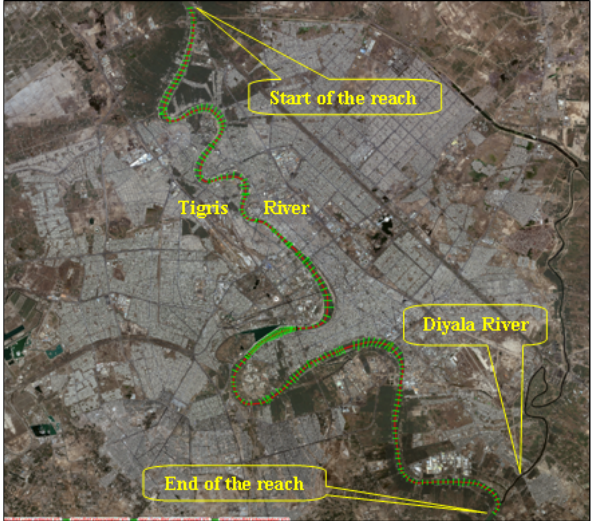
Fig. 11. Cross-sections of Tigris River by